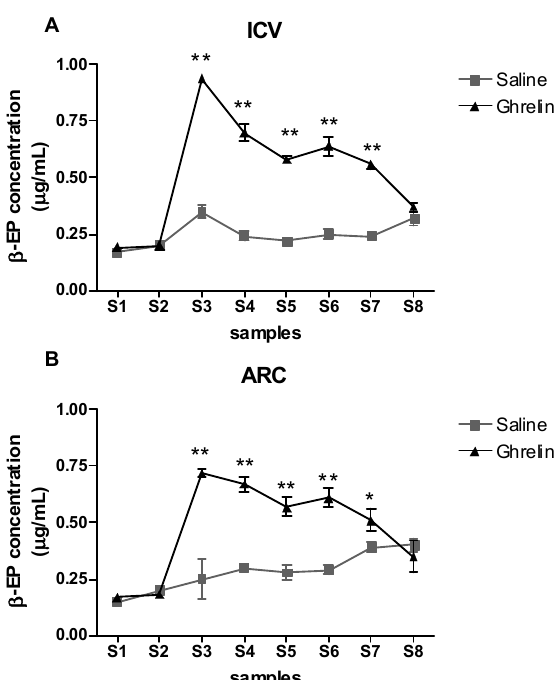
Figure 3. ( A ) Time courses of the β -endorphin ( β -EP) dialysate levels determined before, during and after the formalin test in animals treated with Saline-ICV or Ghrelin-ICV. ( B ) Time courses of the β -EP dialysate levels determined before, during and after the formalin test in animals treated with Saline-ARC or Ghrelin-ARC. Data are mean ± SEM. ** p < 0.001 and * p < 0.05 vs. other group, same time period.